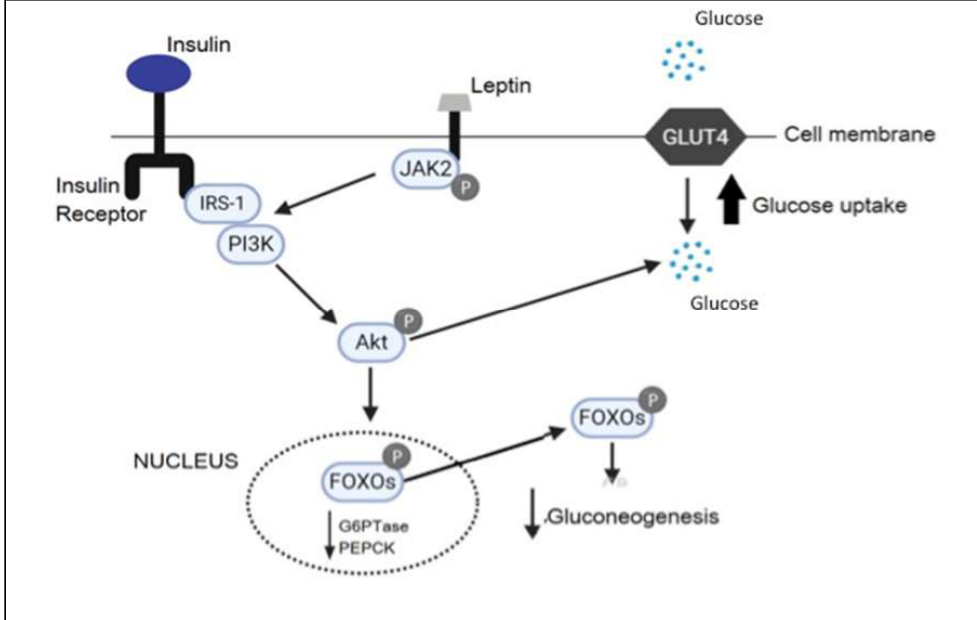
Figure 4. RYGB improves insulin and leptin resistance with consequent IRS-1 phosphorylation to initiate a signaling cascade that involves PIK3. PIK3 activation leads to Akt downstream signaling. The phosphorylation of IRS-1 triggered by PIK3 allows glucose to enter the cell improving blood glucose levels.